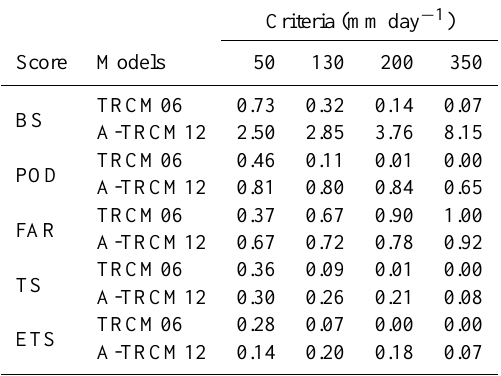
Table 8. Validation results for the statistical parameters of inde- pendent accompanied typhoons that hit Taiwan in 2007–2011 using contingency table